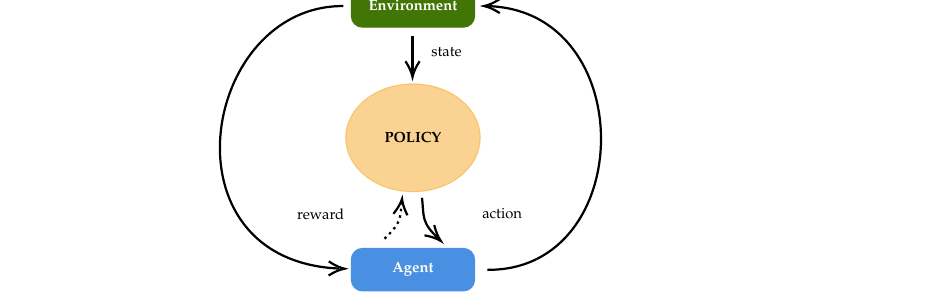
Figure 5. Overview of Reinforcement Learning